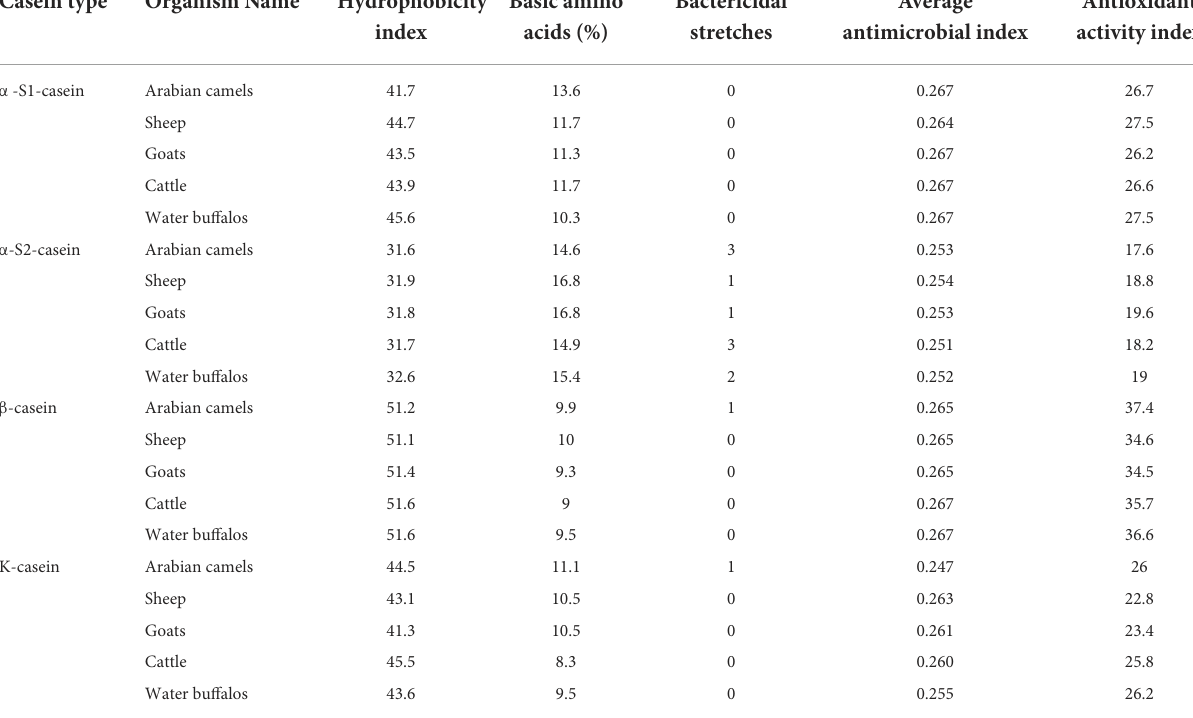
TABLE 4 The computed biological parameters of caseins in five milk-producing